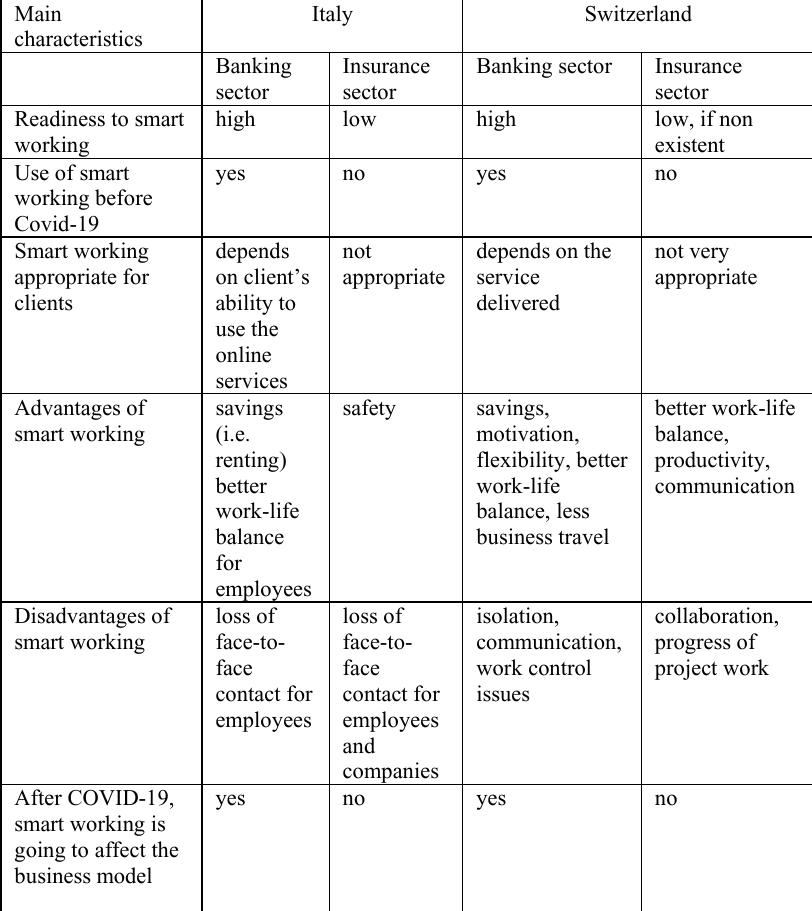
Table 1 : Main features related to smart working in the banking and insurance sectors – Italy and Switzerland Main